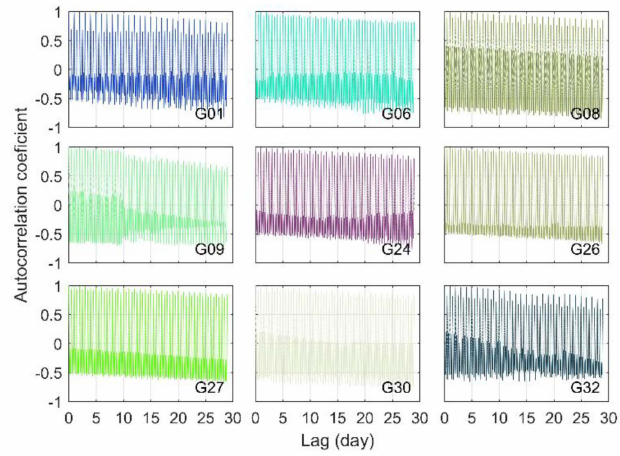
Figure 4. Autocorrelation coefficients of the GPS Block IIF